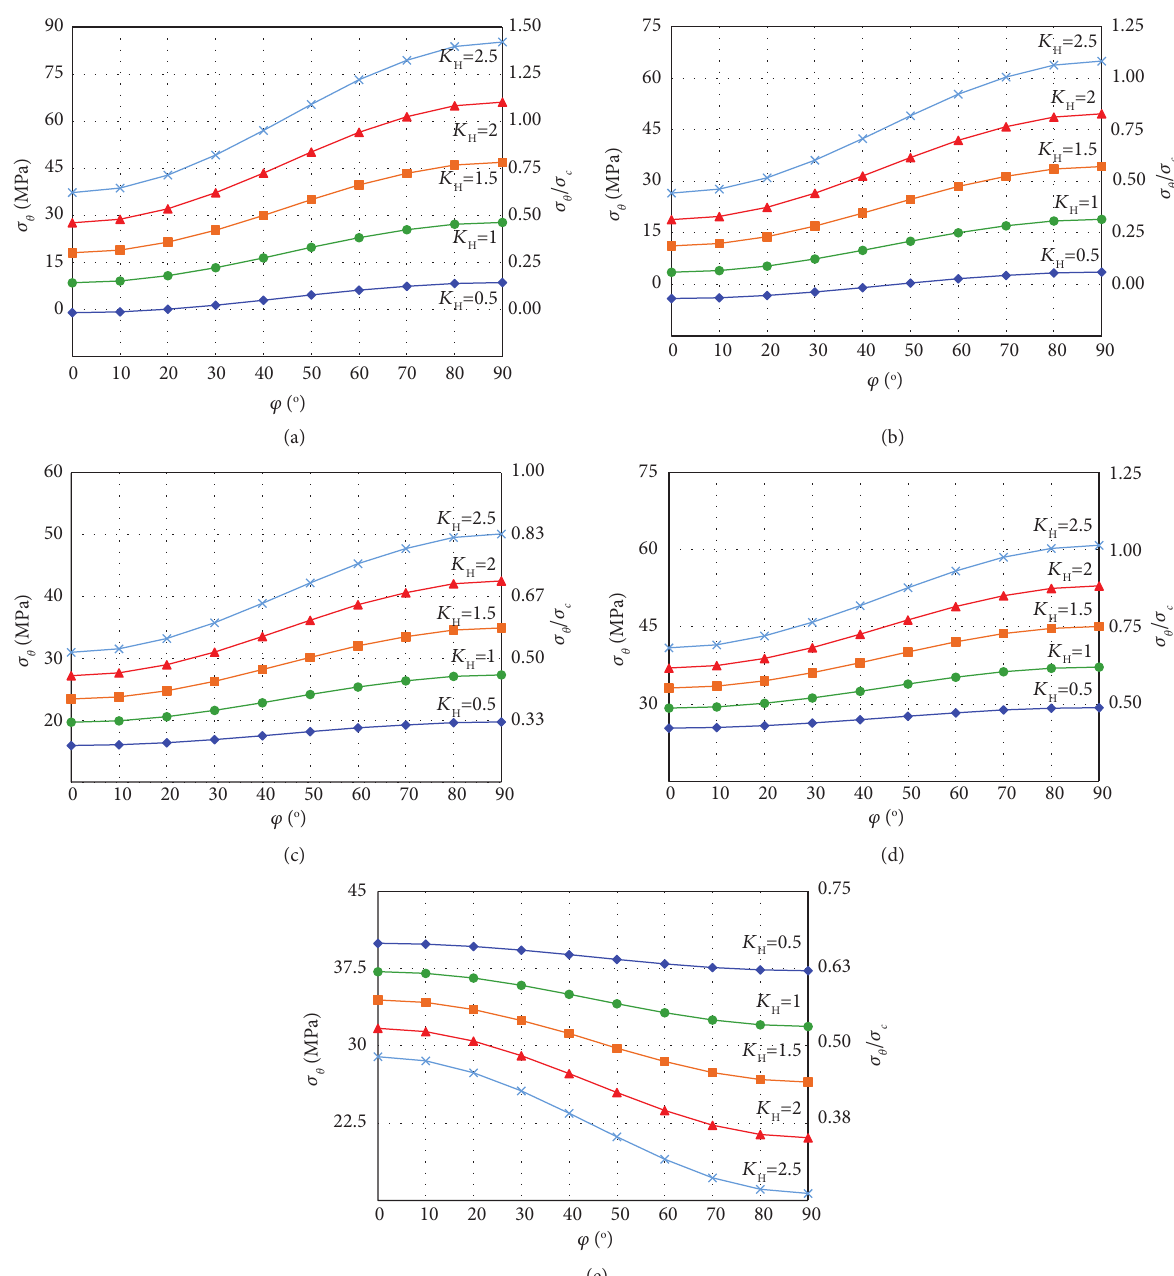
Figure 8: The tangential stress σ and σ / σ c curves at the key positions of the tunnel under various angles φ between the maximum θ θ horizontal principal stress orientation and tunnel axis. (a) Roof. (b) Floor. (c) Spandrel. (d) Corner. (e)